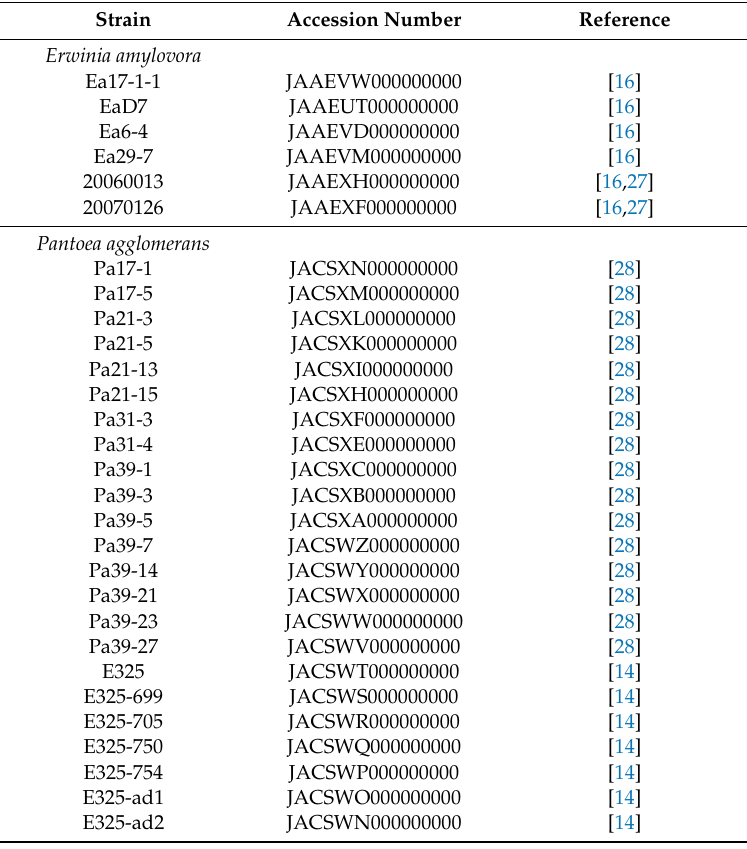
Table 1. Strains of bacteria used in this